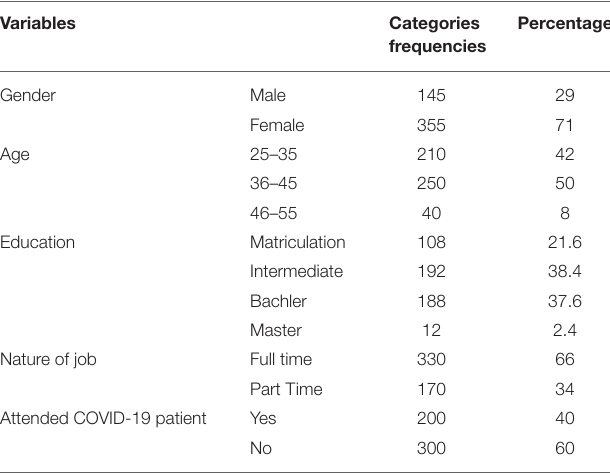
TABLE 1 | Demographic profile of participants ( N = 500).